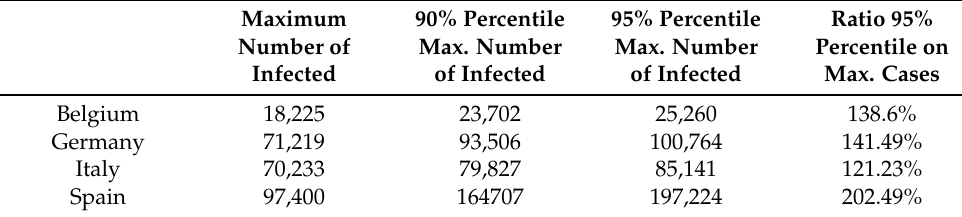
Figure 7. Simulations of 1000 sample paths of I t , with parameter estimates in Table 9 and constant J . The thick dotted blue line is the expectation of I t , whereas the thick black line is the observed number of infected cases. Table 10. Statistics about the observed and simulated epidemic peaks (1000 simulations).